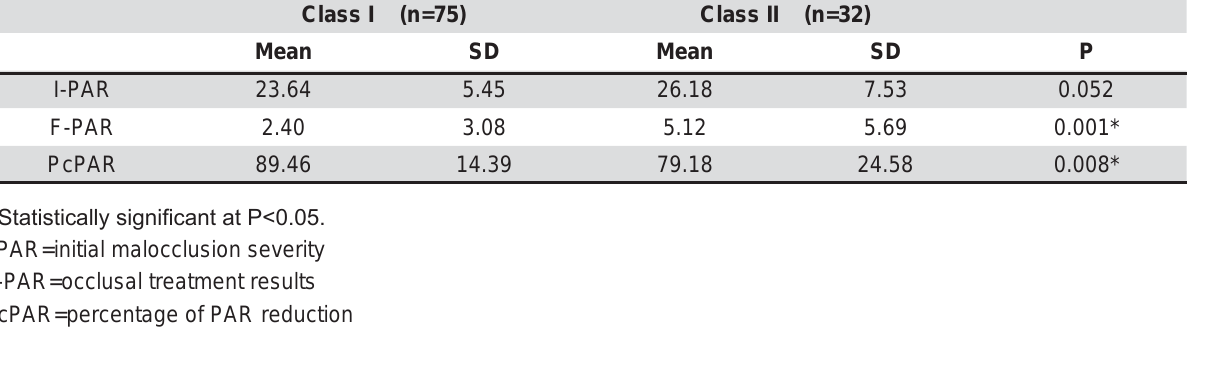
Table 2 - Comparison of Class I and complete Class II malocclusion groups regarding PAR score